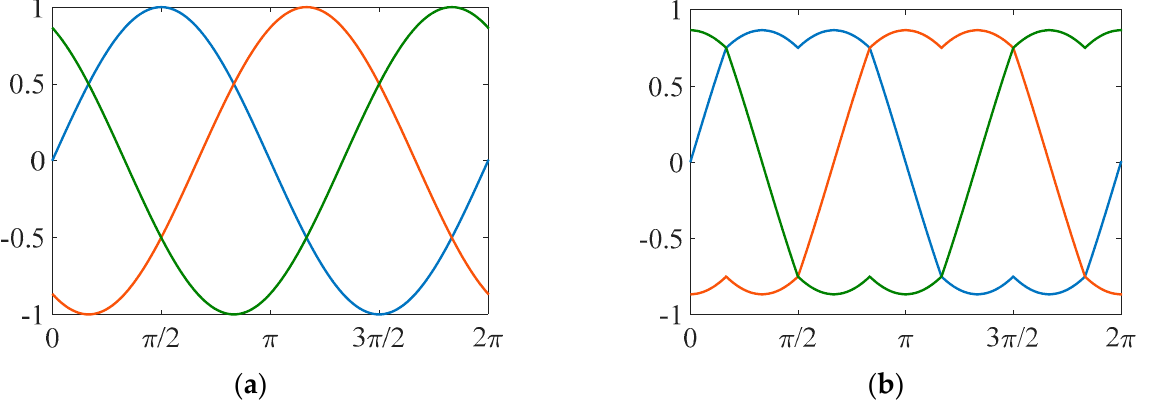
Figure 4. Modulation signals with modulation index equal to 1: ( a ) sinusoidal; ( b ) Switching Frequency Optimal—SFO.